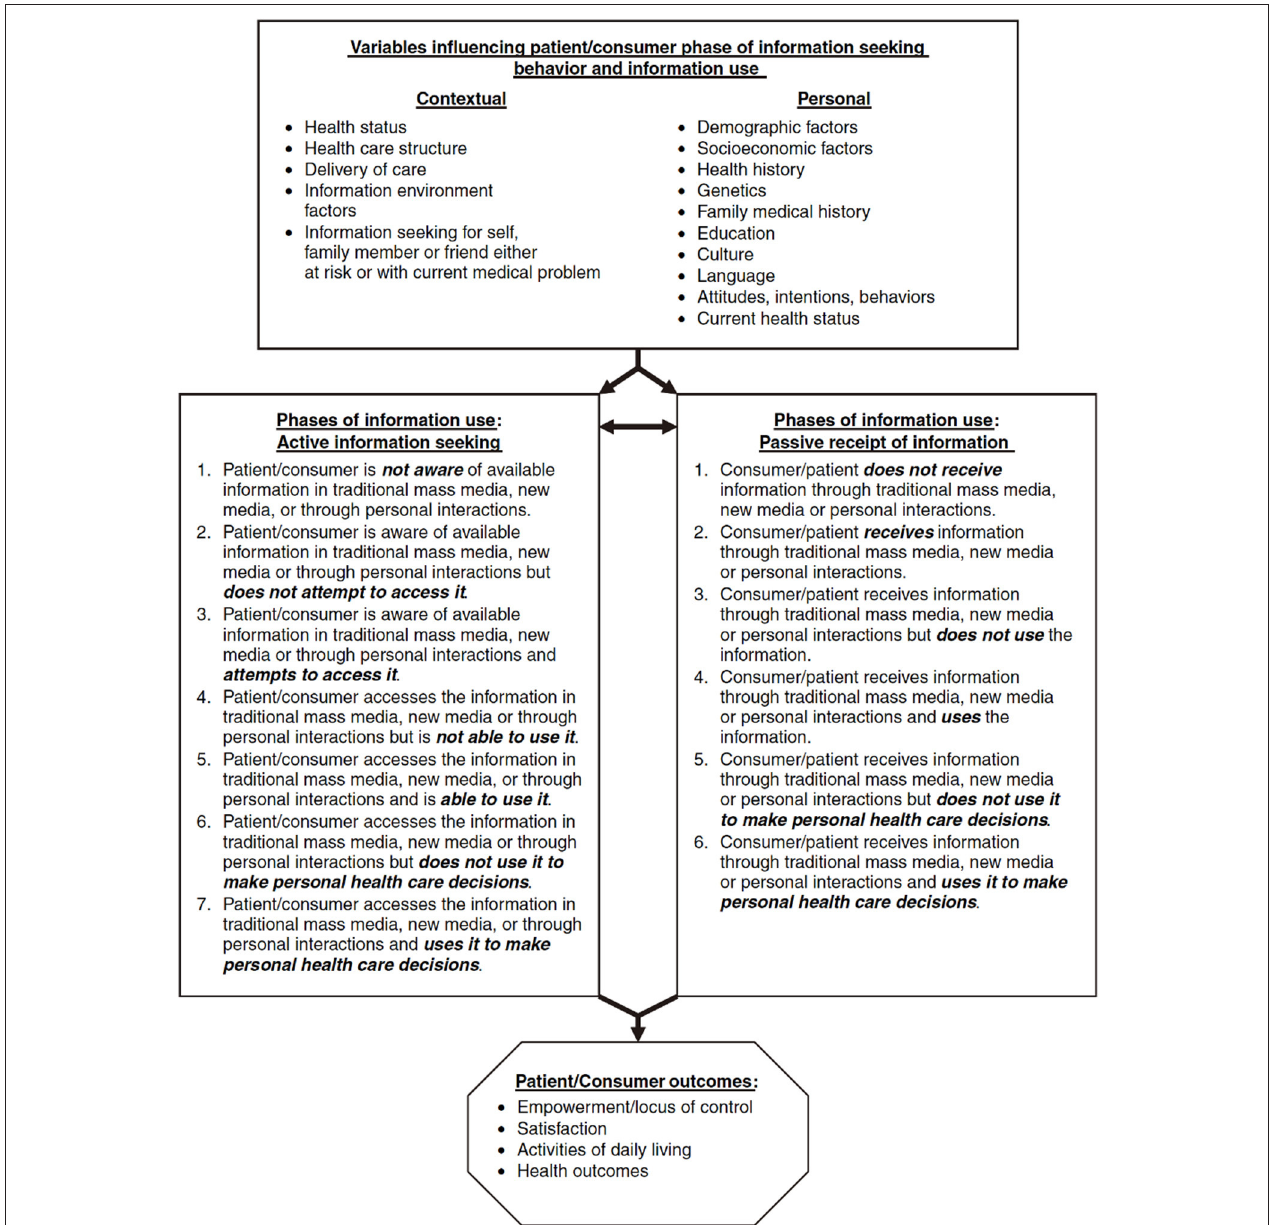
FIGURE 6 | Longo’s extended model of health information seeking